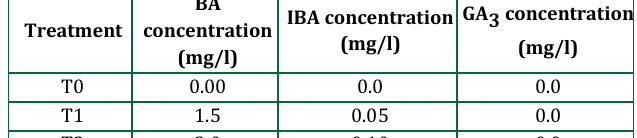
Table 1: Different concentrations and combinations of IBA, BA and GA3 added to MS medium for shoot and root induction Treatment